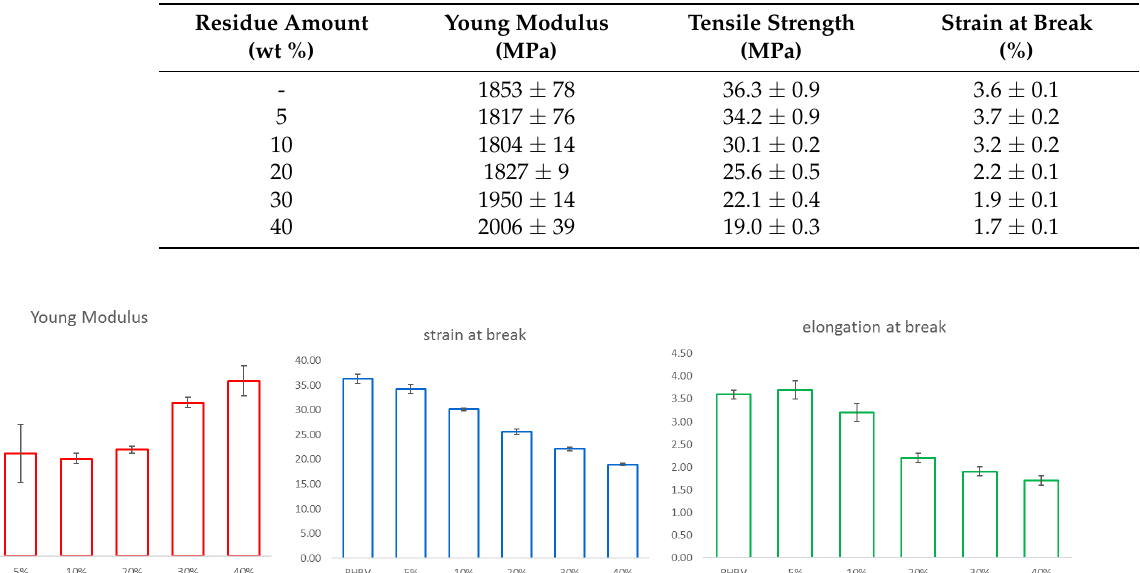
Table 5. Tensile data for composites prepared at 180 ◦ C.